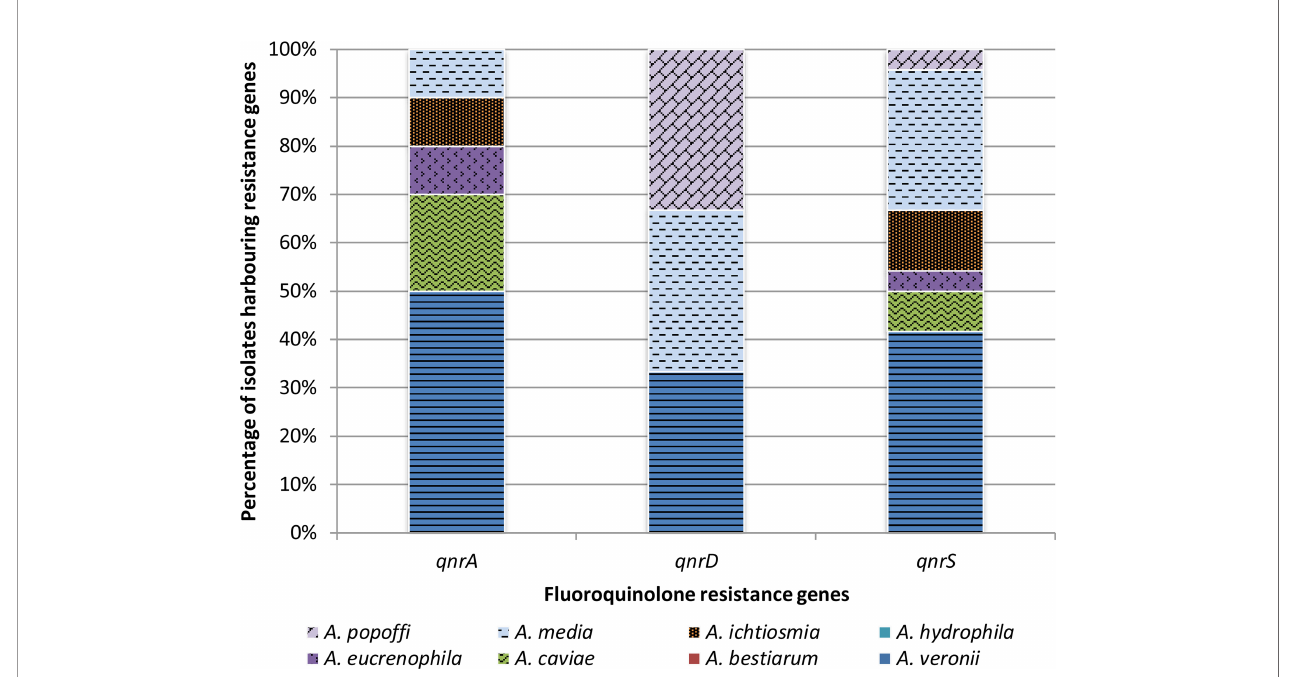
FIGURE 5 | Presence of plasmid-mediated fl uoroquinolone resistance genes in different species of Aeromonas bacteria isolated from freshwater samples.